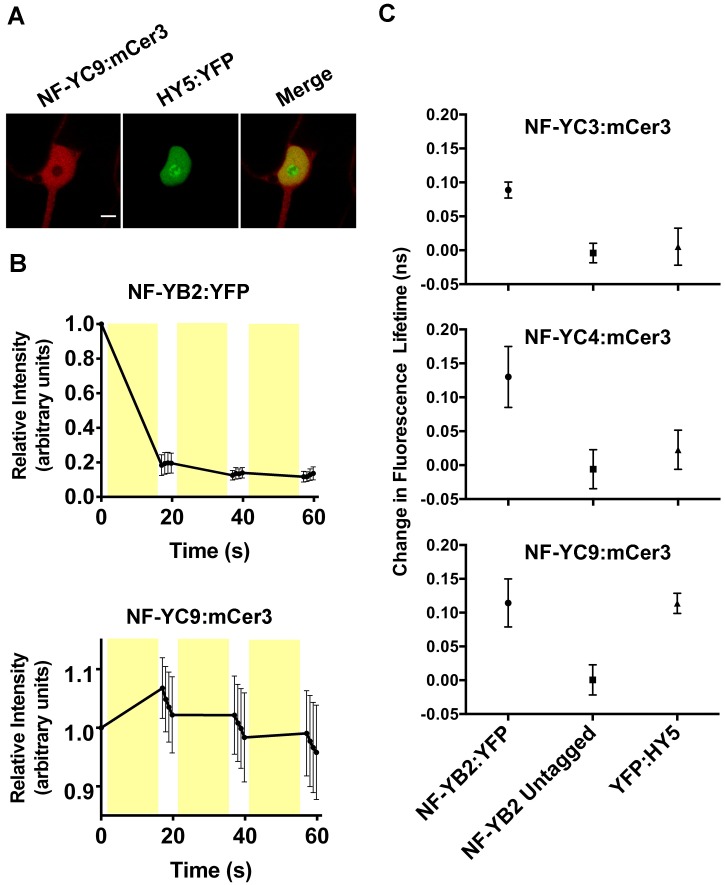
FRET-FLIM analysis shows a strong NF-YC9 by HY5 physical interaction.FRET experiments were conducted in tobacco leaves through transient 35S-driven overexpression of NF-YCs tagged with mCer3 and HY5 or NF-YB2 tagged with YFP. A) Nuclei expressing both mCer3 and YFP constructs were assayed for FRET through both FRAP and FLIM. B) A FRAP curve representative of a positive FRET result between two known interacting proteins, NF-YB2 and NF-YC9. Fluorescence intensity was calculated relative to the pre-photobleached intensity of each fluorescent protein. Yellow bars represent the timing of photobleaching events. C) FLIM was employed to detect FRET through lifetime measurements before and after acceptor photobleaching (FRAP) within the same nucleus. Each point is an independent combination of mCer3- and YFP-tagged proteins, and represents the shift in fluorescent lifetime elicited by acceptor photobleaching. Scale bar in A) represents 5μm. Error bars in B-C) represent 95% confidence intervals with an n ≥ 3.